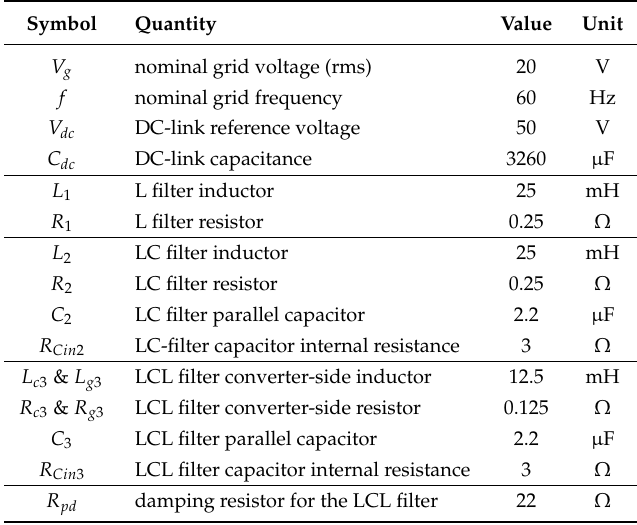
Table 2 specifies all of the experiments’ parameters. The damping resistor for the LCL filter is R pd + R Cin = 25 Ω for conventional vector control. The NN controller was retrained based on Table 2. The sampling time T s = 0.1 ms was used for all hardware experiments. Table 2. The system parameters in the hardware